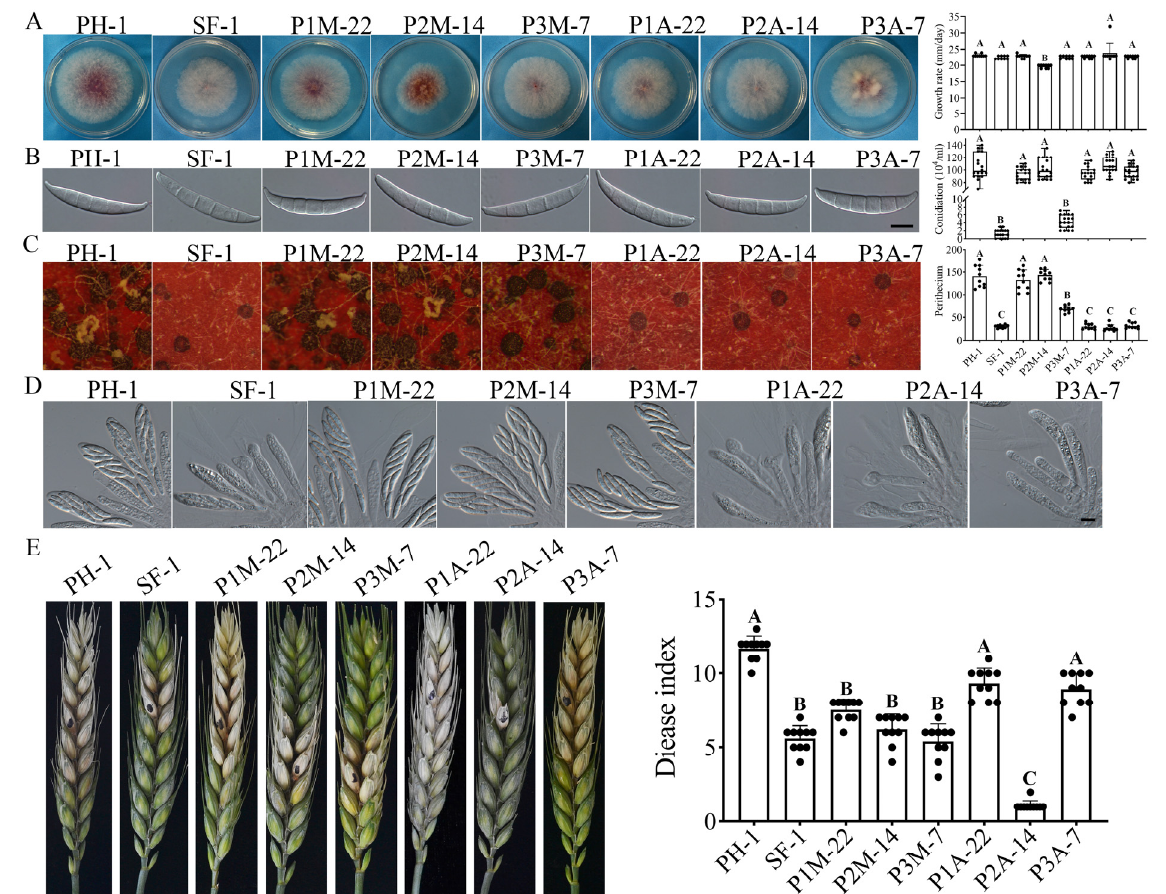
Figure 7. Phosphorylation site of FgSFL1 is important in conidiation, sexual reproduction, and plant infection. ( A ) Three- day-old PDA cultures of the wild-type strains PH-1, P1M-22, P2M-14, P3M-7, P1A-22, P2A-14, and P3A-7. ( B ) Conidiation of the wild-type strains PH-1, P1M-22, P2M-14, P3M-7, P1A-22, P2A-14, and P3A-7 after cultivation in CMC for five days. Bar = 20 µ m. ( C ) Carrot agar cultures of the wild-type strains PH-1, P1M-22, P2M-14, P3M-7, P1A-22, P2A-14, and P3A-7 were examined 7 days post-fertilization (dpf) and assay of perithecia of the wild-type strains PH-1, P1M-22, P2M-14, P3M-7, P1A-22, P2A-14, and P3A-7. ( D ) Ascospores of the wild-type strains PH-1, P1M-22, P2M-14, P3M-7, P1A-22, P2A-14, and P3A-7 were examined by differential interference contrast (DIC). Bar = 10 µ m. ( E ) Flowering wheat heads were drop-inoculated with conidia of the same set of strains and photographed 14 days post-inoculation (dpi). Black dots mark the inoculated spikelets. Different letters indicate significant differences based on ANOVA analysis followed by Duncan’s multiple range test ( p = 0.01) in A, B,